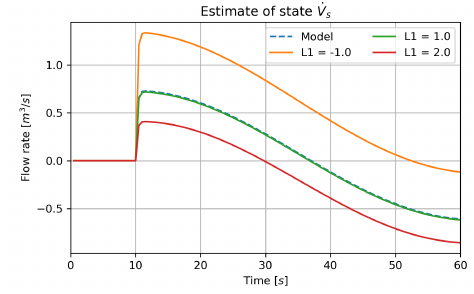
Figure 3: Observer behavior when only measurement x 1 is injected. Gain L 1 is varied to study its effect on